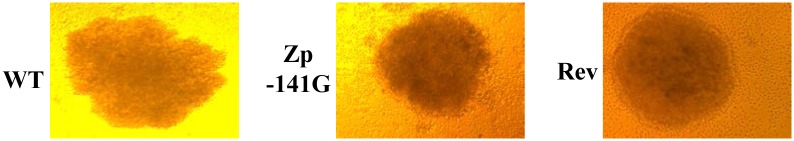
The Zp-V3 B95.8 mutant is not defective for transforming primary B cells.Primary peripheral B cells were infected with wildtype, Zp-141G mutant, and revertant virus (MOI 0.25) and maintained for 21 days. 10/10 wells had colony outgrowth for each virus. Representative bright field images from each strain are shown.